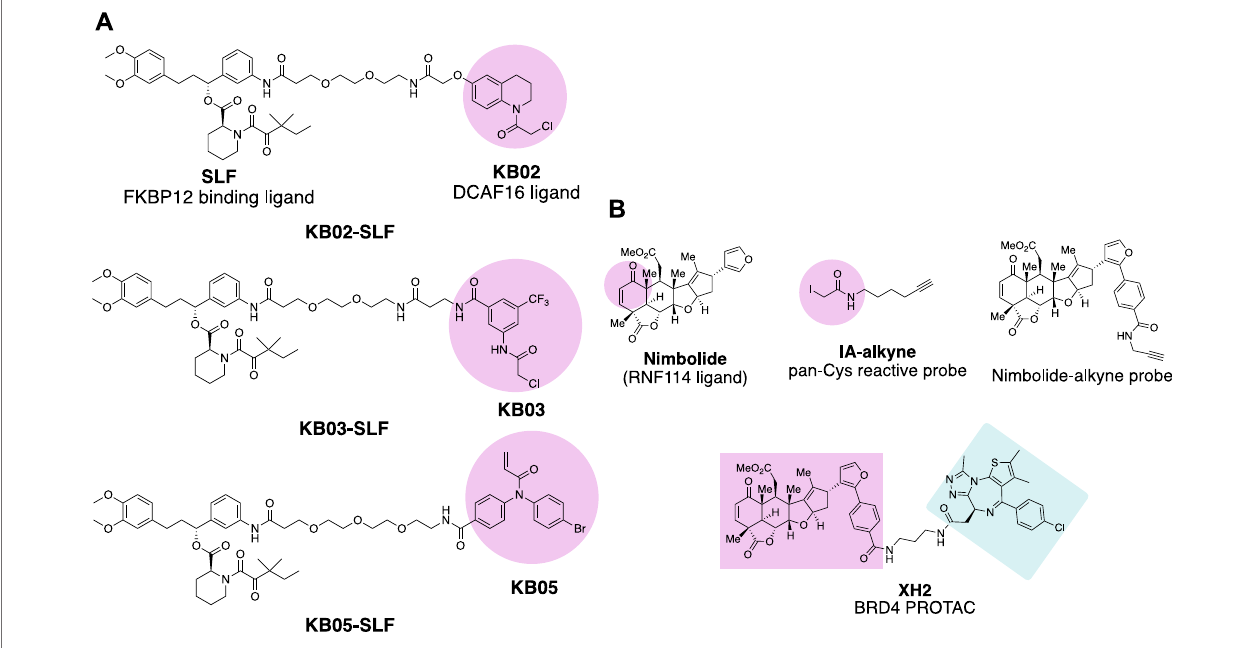
FIGURE 2 | Chemical probes for the identi fi cation of E3 ligases. (A) FKBP12 degrading molecules with “ scout ” fragment KB02, KB03, and KB05 covalently react with Cysteine in the proteome. (B) Chemical probes for the identi fi cation of E3 ligase recruited by Nimbolide .